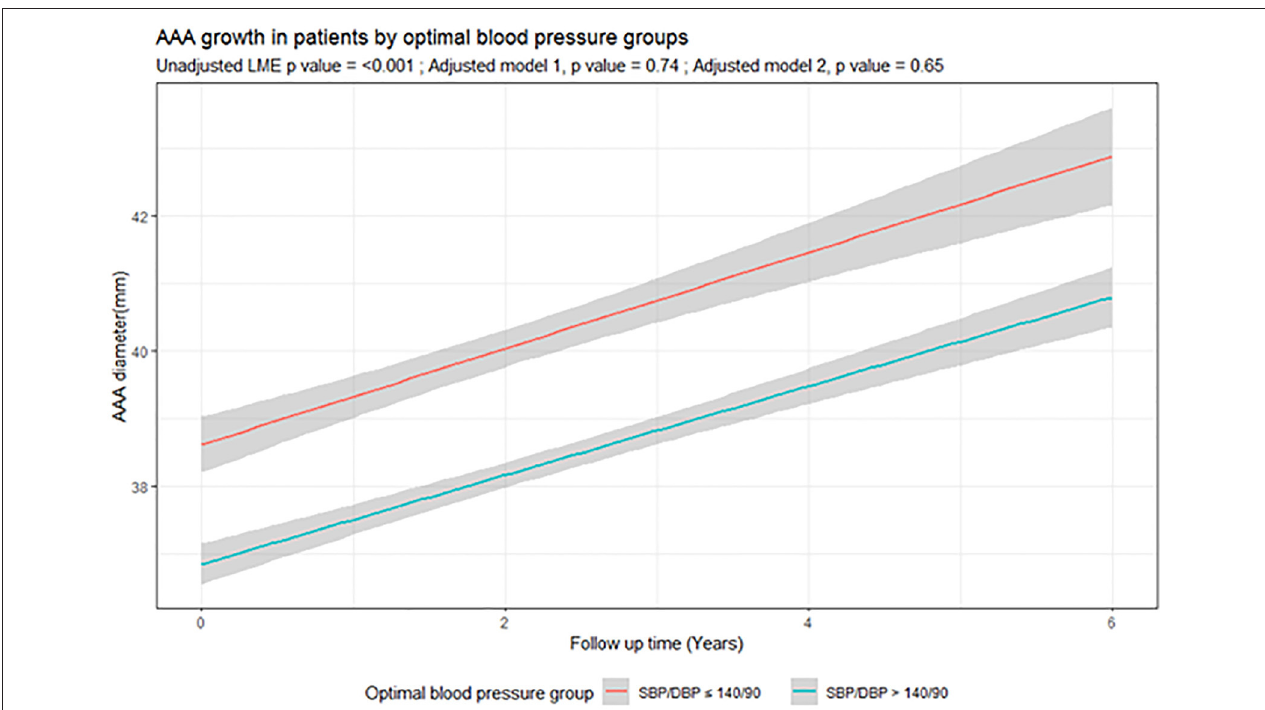
FIGURE 1 | Association of optimal blood pressure with abdominal aortic aneurysm growth. The graph illustrates the mean growth (95% CI) of AAA growth during follow up (years) according to optimal blood pressure in AAA patients. The red line represents patients with BP ≤ 140/90 mmHg and the green line represents patients with SBP > 140 or DBP > 90 mmHg. BP, blood pressure; DBP, diastolic blood pressure; SBP, systolic blood